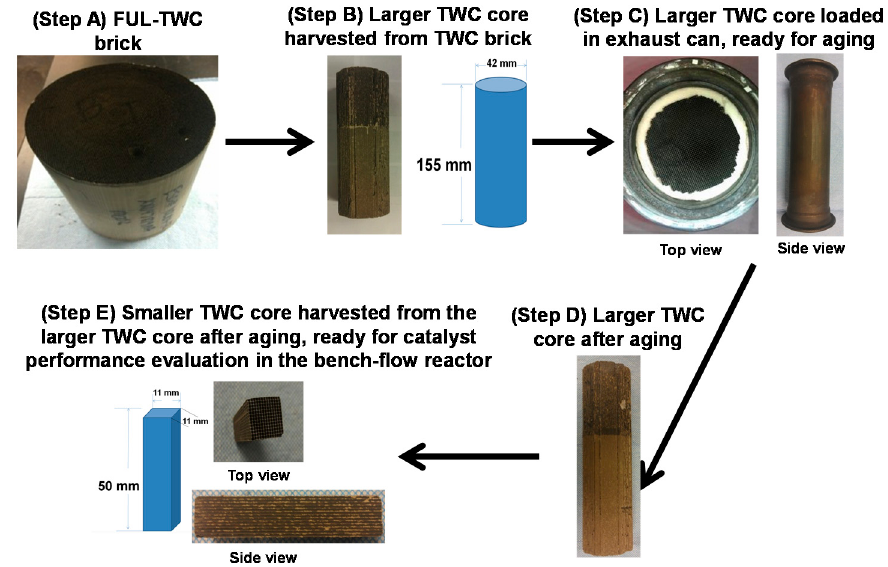
Figure 13. Sample preparation steps for engine aging and catalyst evaluation in bench ‐ flow reactor.